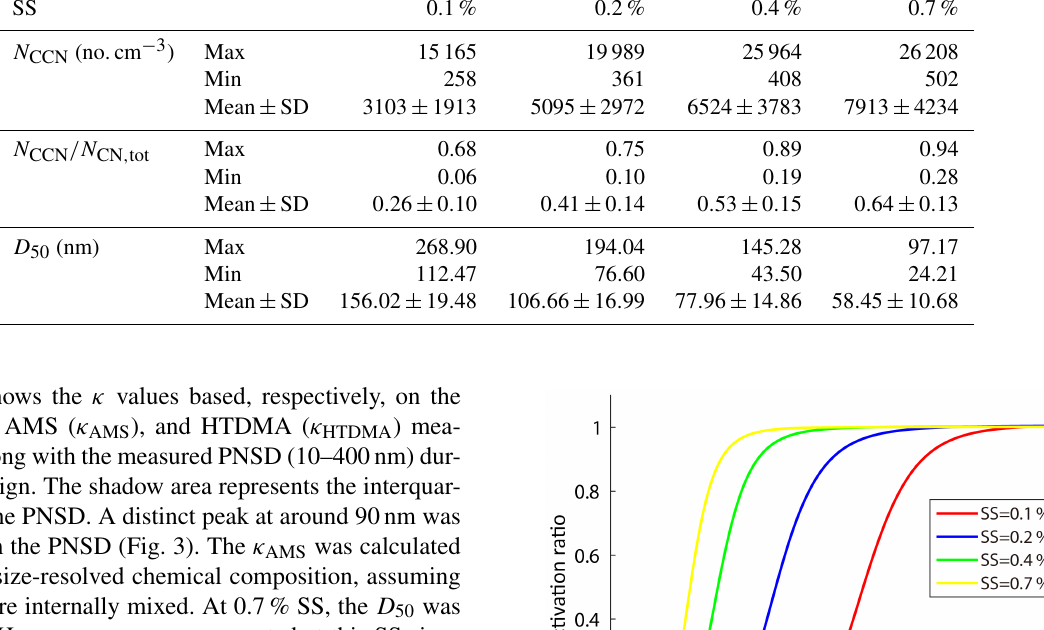
Table 2. Summary of the measured CCN concentration, activation ratio, and D 50 at the four supersaturations during the campaign. SS 0.1%